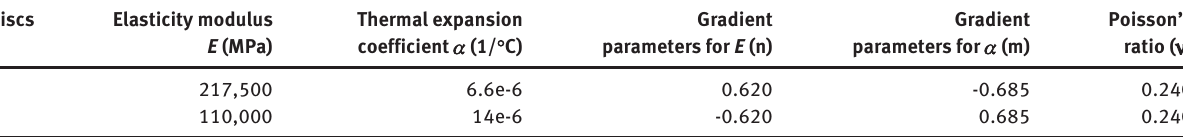
Table 1 Mechanical properties of the discs.